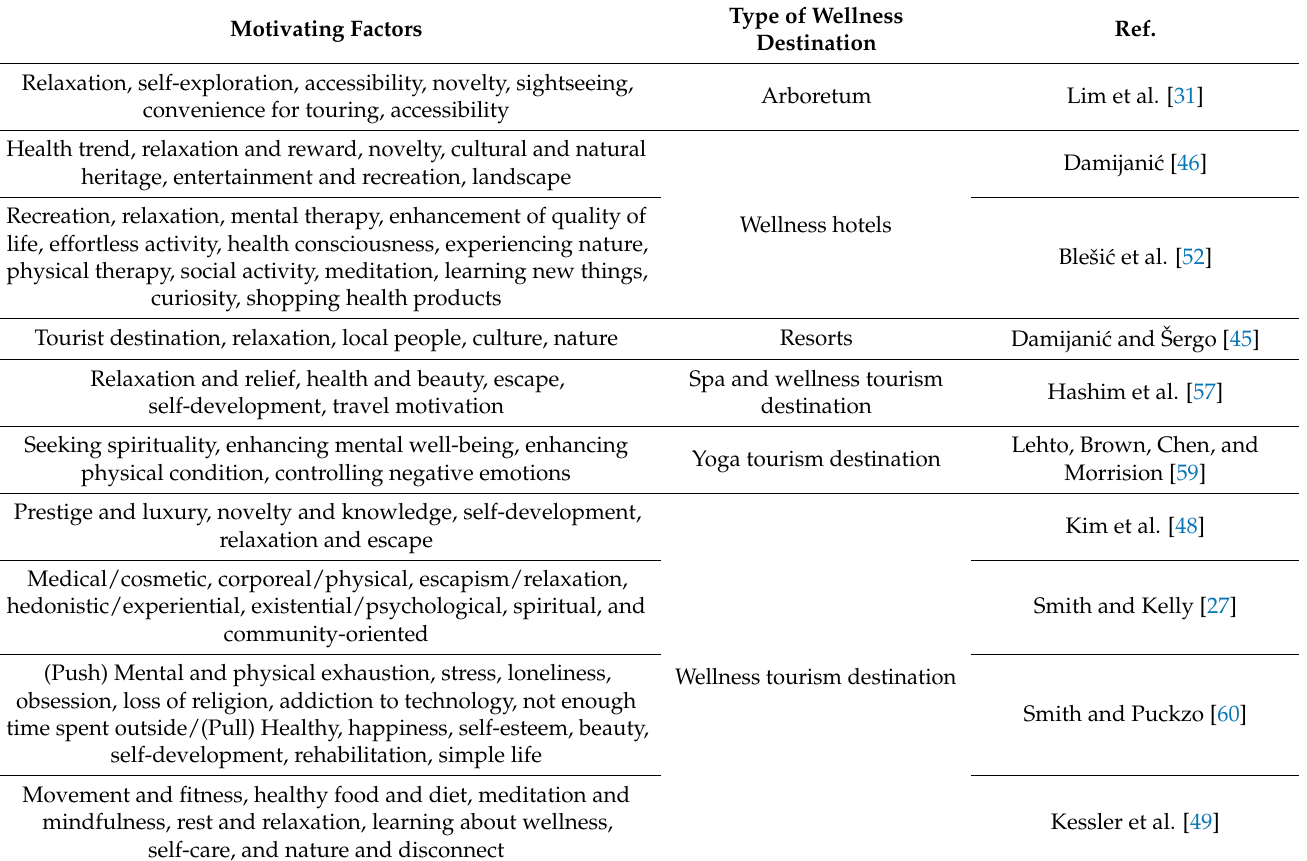
Table 2. Prior studies of motivation of wellness tourism.